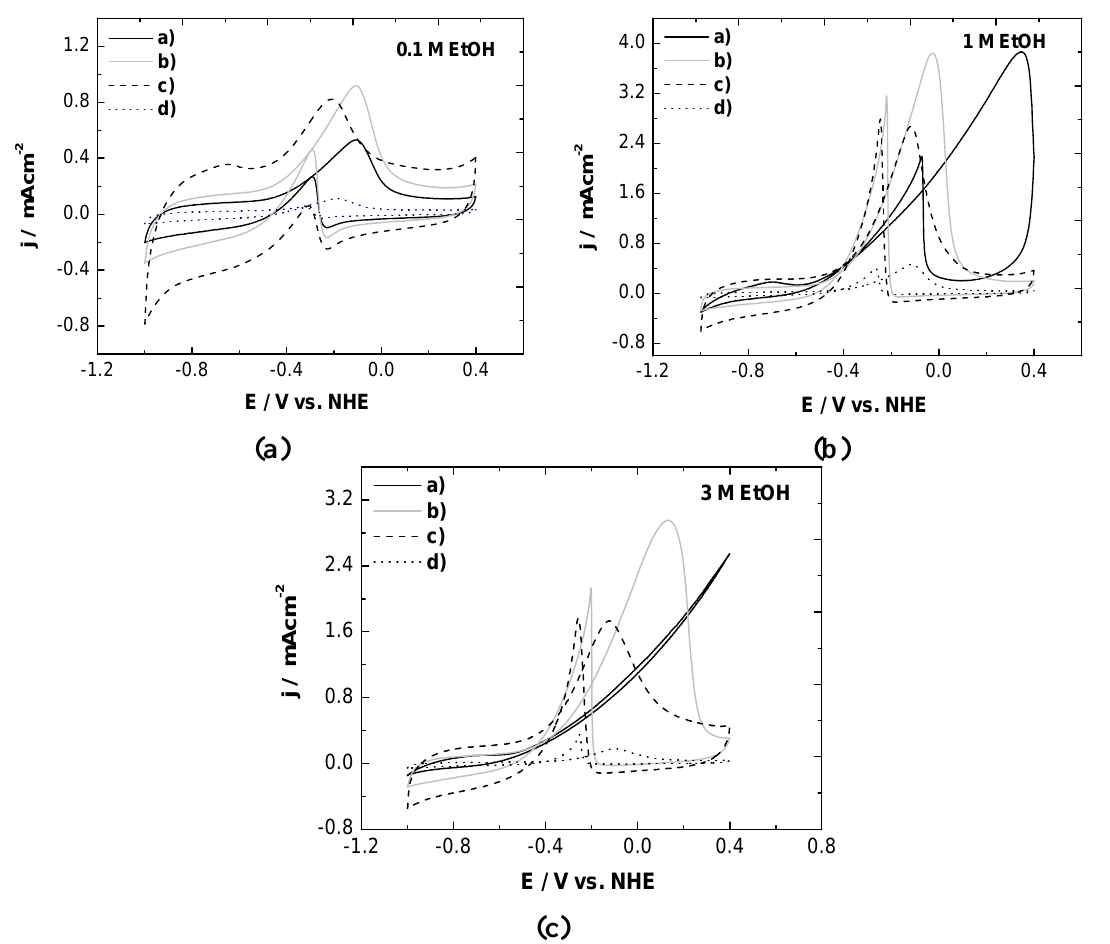
Figure 5. Cyclic voltammograms of Pd catalysts in 1 M KOH + : ( a ) 0.1; ( b ) 1; and ( c ) 3 M ethanol at room